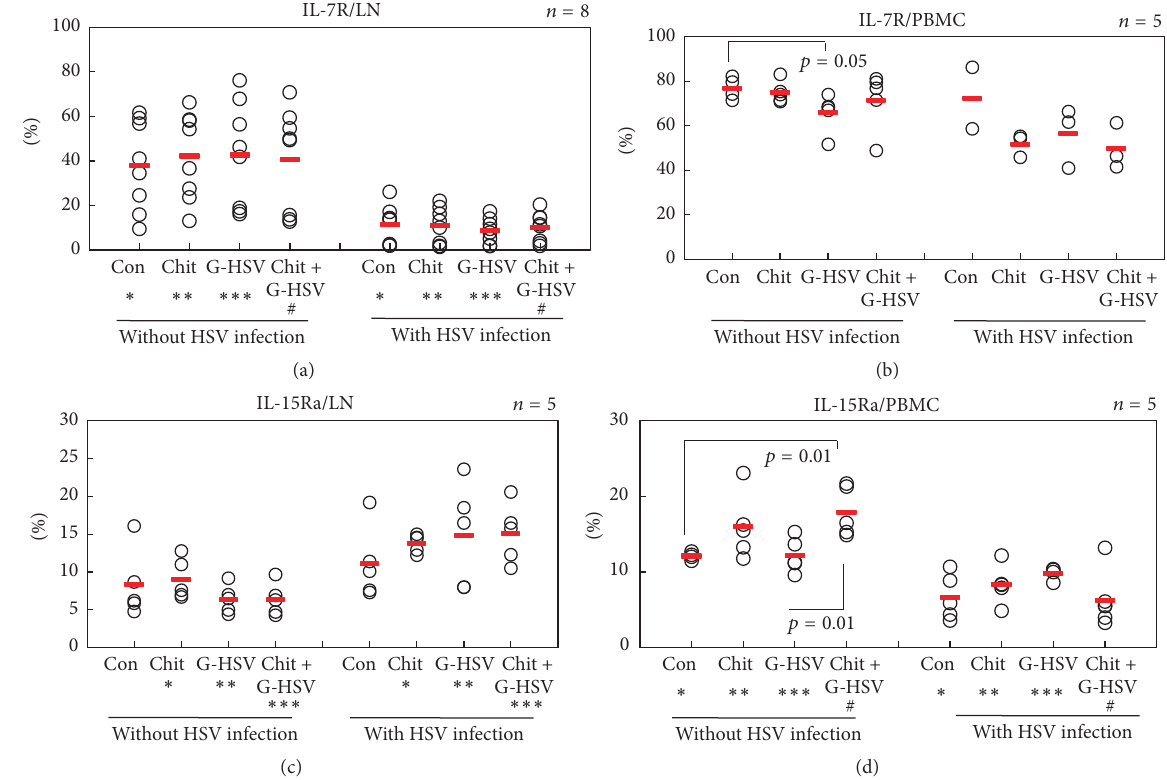
Figure 2: Correlation of IL-7R expression and IL-15R 𝛼 expression in lymph node and PBMC of HSV infected mice. The frequencies of IL-7R +